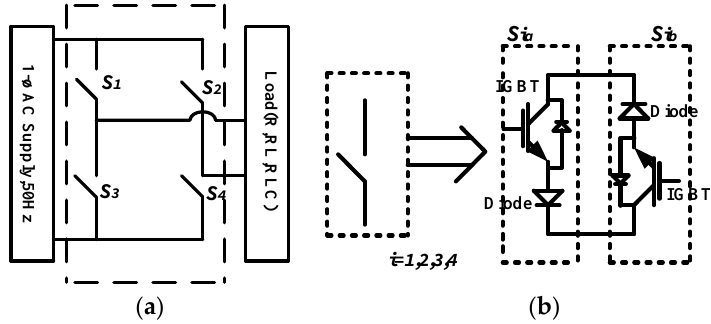
Figure 2. ( a ) 1-ø matrix converter topology and ( b ) bi-directional switch (common emitter Figure 2. configuration mode).